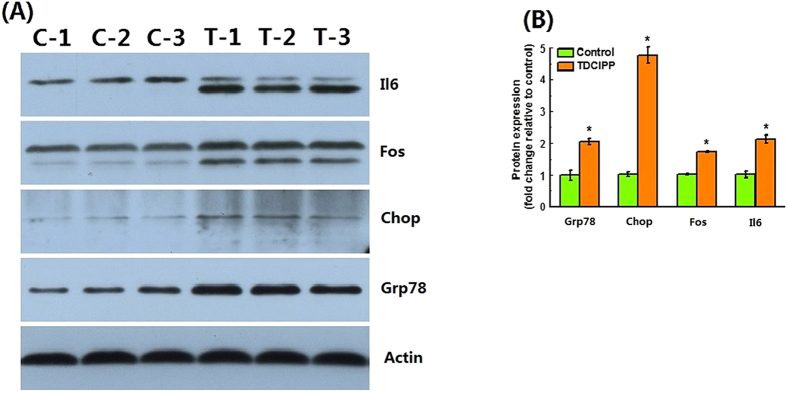
Effects on expressions of four proteins selected (Grp78, Chop, Fos and Il6) in response to 1 mg/L TDCIPP.(A) Western blots of four proteins selected from control and TDCIPP groups; (B) Quantification of the relative expressions of four proteins selected in control and treatment groups. C: control group; T: treatment group. Values represent mean ± SEM (n = 3). Asterisks indicate significant differences from matched control samples (P < 0.05).